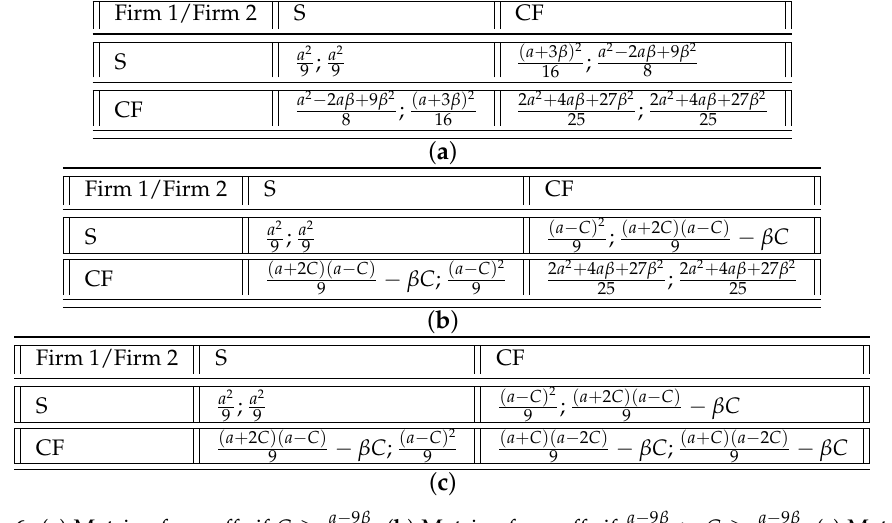
; ( b ) Matrix of payoffs if a 4